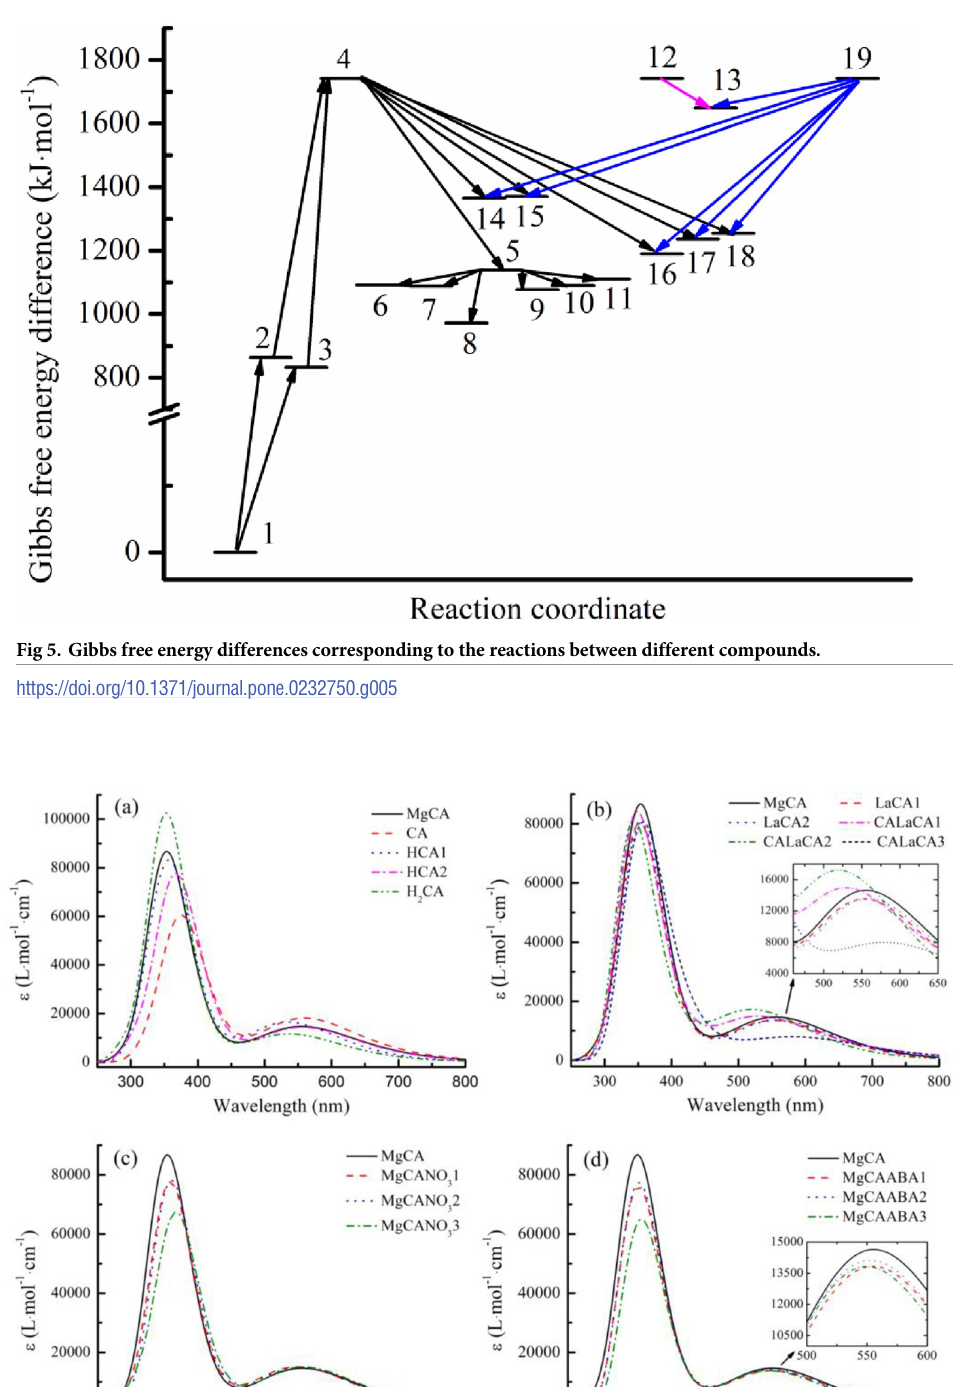
PLOS ONE | https://doi.org/10.1371/journal.pone.0232750 May 5,